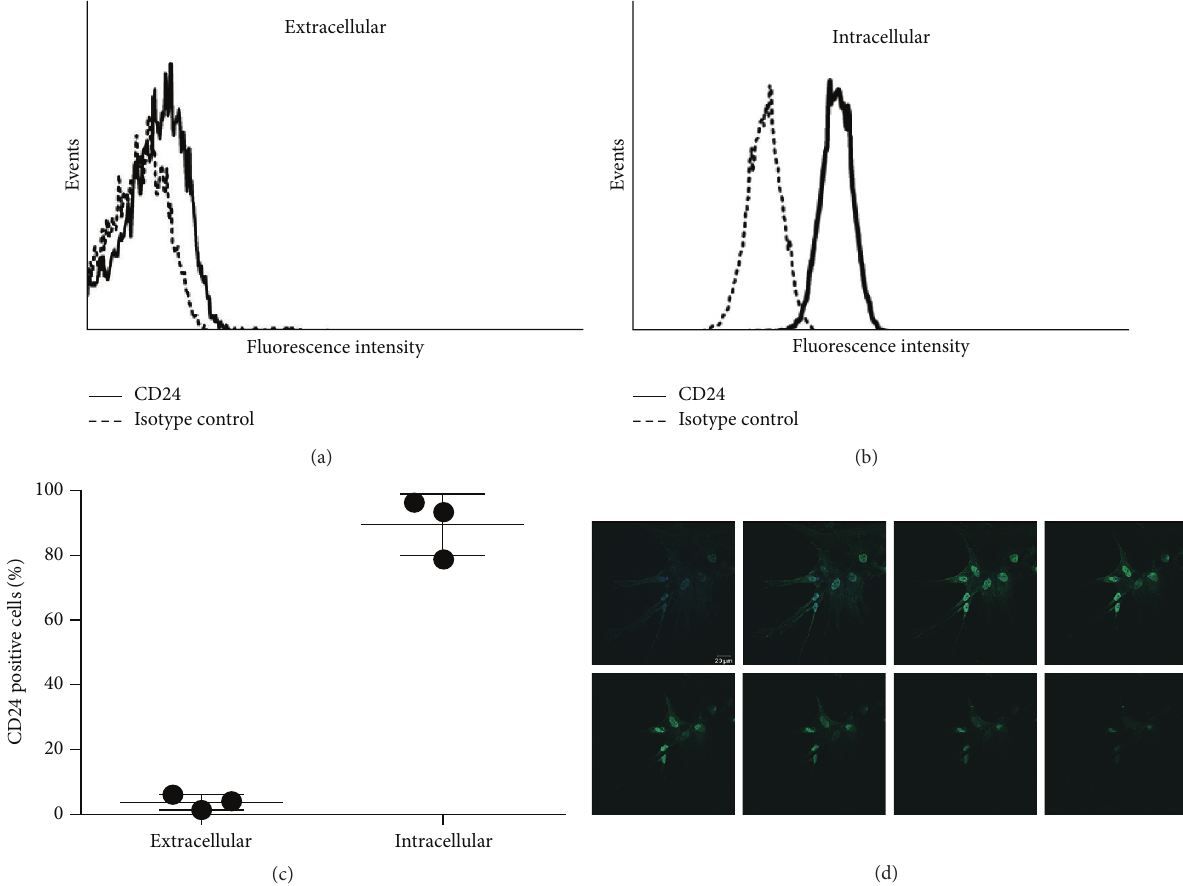
Figure 2: Cellular localisation of CD24. (a), (b), and (c) hBMSCs were analyzed by flow cytometry for the expression of CD24 protein. An exemplary histogram depicting the low extracellular CD24 expression can be found in (a); an exemplary histogram depicting the high intracellular CD24 protein density is shown in (b). (c) shows the percent expression of CD24 protein extra- and intracellularly in three independentexperimentswithhBMSCsfromdifferentdonors.(d)ImmunocytochemicalanalysisoftheintracellularCD24proteinexpression showing a diffuse cytosolic and a strong nuclear reactivity. A z-stack image is shown to highlight the nuclear localisation of CD24 (monoclonal anti-CD24 antibody, clone ML-5). Green = CD24. Blue = nuclear staining. Scale: 20 𝜇 m. A high resolution image of (d) can be found in Supplemental Figure